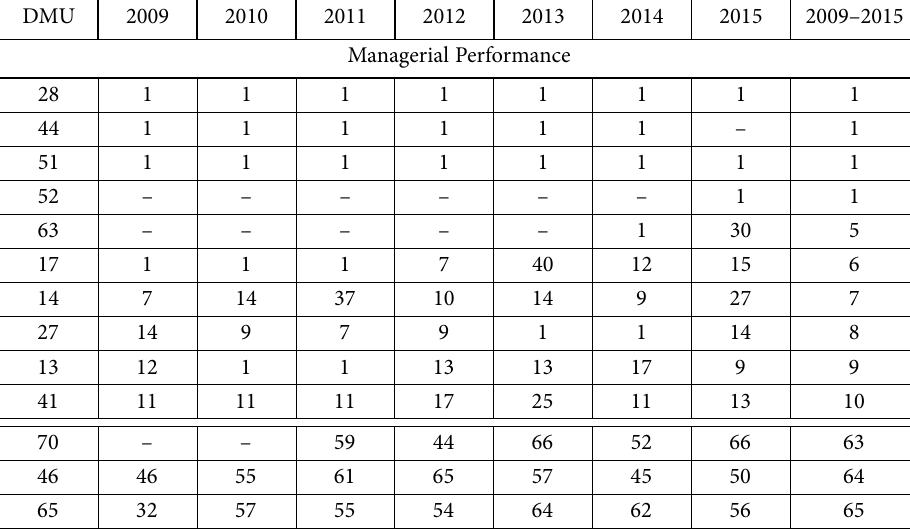
Table 5. The rank results of ICA-NSBM model for Taiwanese international tourist hotels